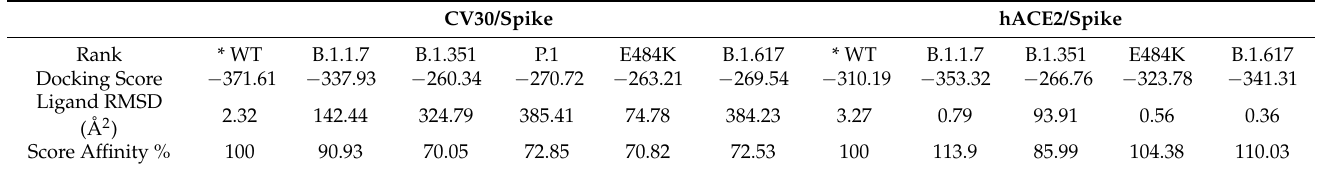
Figure 3. Docking structures of the interaction of SARS-CoV-2 S-RBD protein in complex with a potent neutralizing CV30 antibody. The structure of interactions of the wild S-RBD protein with neutralizing CV30 antibody ( a , c ). Docking structure of interactions of mutant S-RBD protein with neutralizing CV30 antibody ( b , d ). Table 1. Docking score of binding of S-RBD region of different novel variants with neutralizing CV30 antibody and